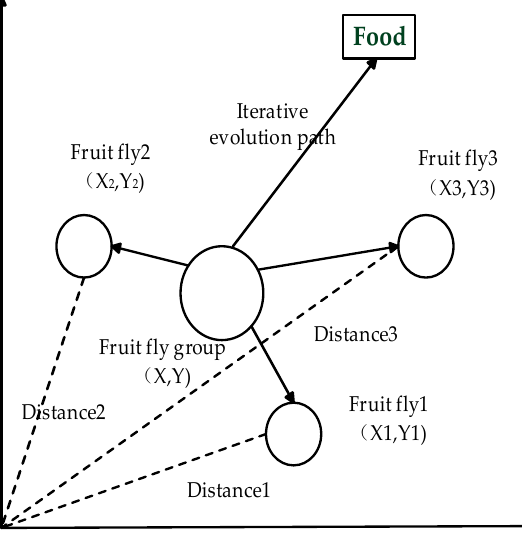
Figure 1. Iterative food searching process of the fruit fly swarm.